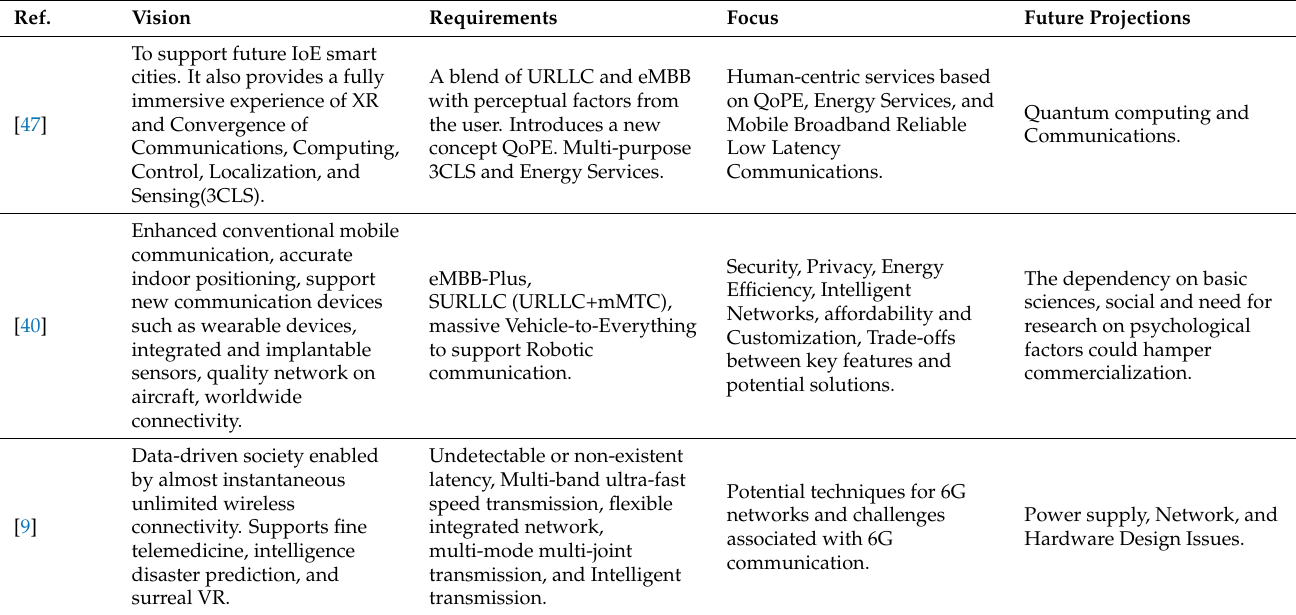
Table 4. A summary of the vision and requirements of 6G wireless networks.